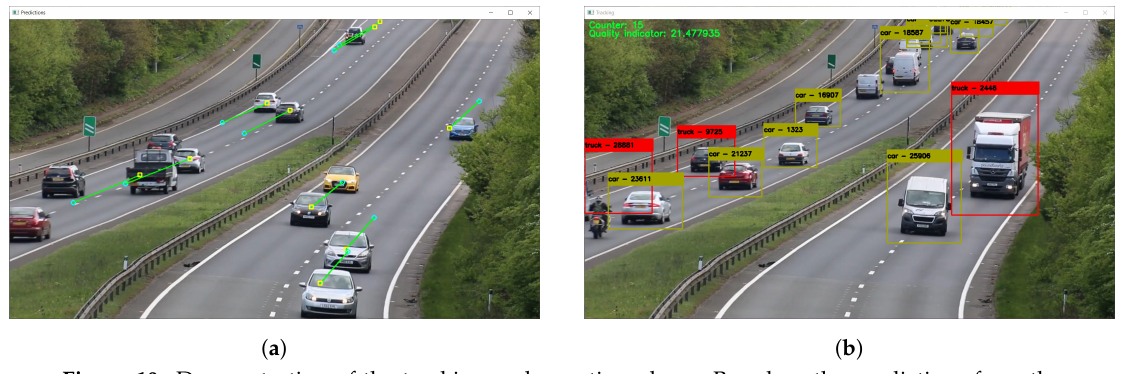
Figure 10. Demonstration of the tracking and counting phase. Based on the predictions from the prediction model ( a ), the tracking component can track objects successfully ( b ). Additionally, passed by objects are counted with help of the tracking